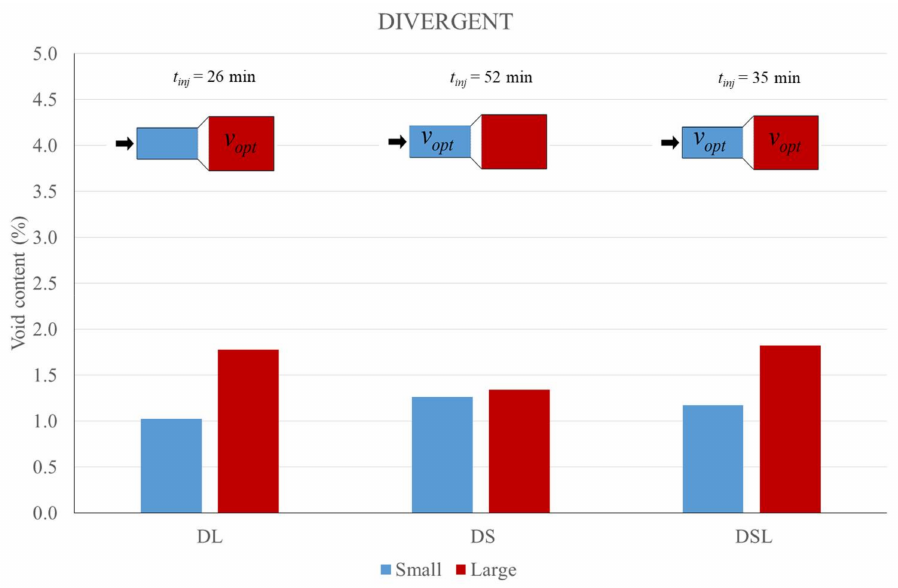
Figure 12. Void content analysis averaged by section for the divergent